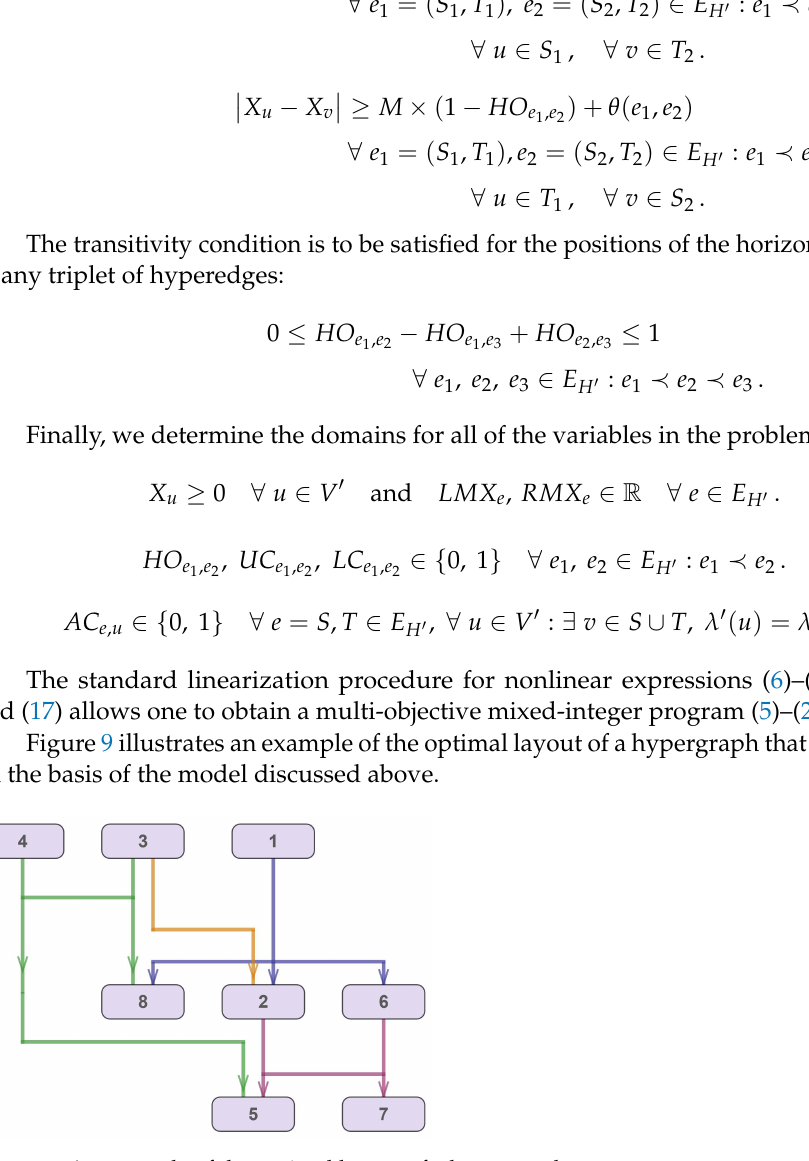
Figure 9. An example of the optimal layout of a